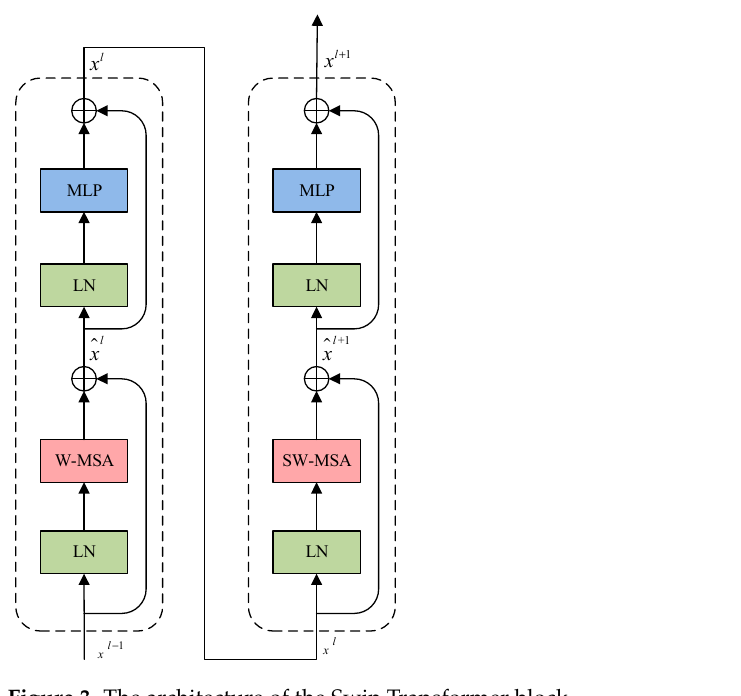
Figure 3. The architecture of the Swin Transformer block.